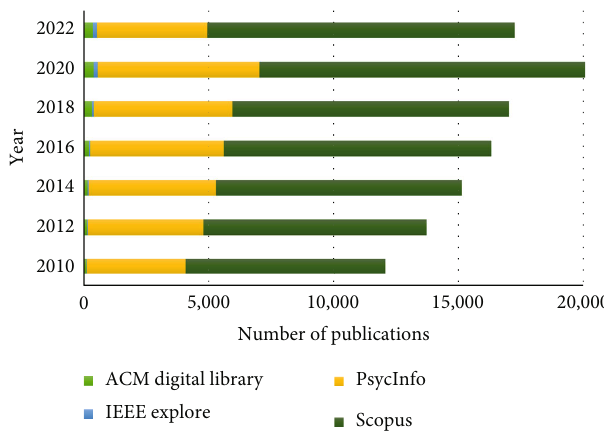
Figure 1: Number of publications concerning “ suicide ” in four databases between 2010 and